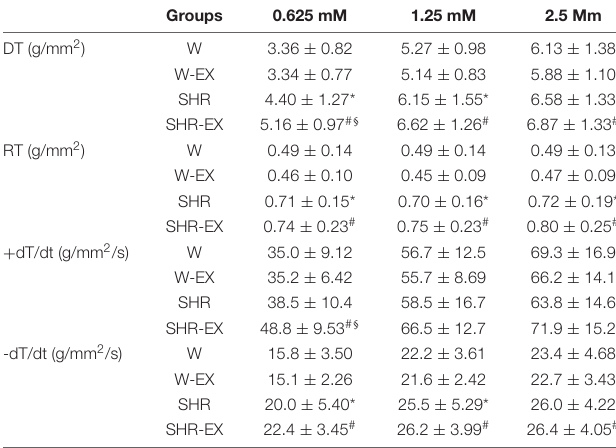
TABLE 5 | Papillary muscle function after changes in extracellular calcium